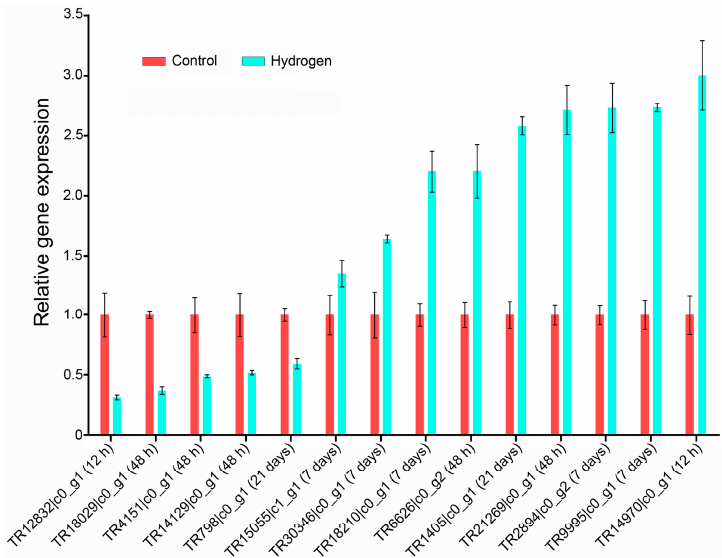
Figure 4. Verification of DEGs using qPCR (real-time quantitative PCR). Three biological repeats were reverse transcribed and amplified independently in the qPCR. The samples were quantified using LaEF-1 α as a reference gene and the data are presented as mean ± standard error. The time point of differential expression is shown in parentheses for each gene.